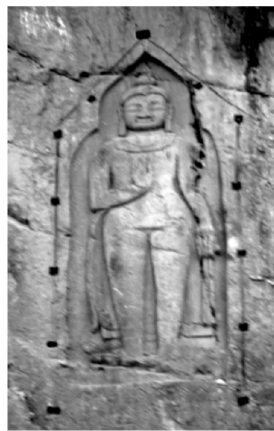
Figure 22. Colossal Buddha, seventh to eighth century. Carved into cliffs at Kargah near Gilgit. https://explorebeautyofpakistan.com/gilgit-baltistan/gilgit-region/kargha-budhha/.